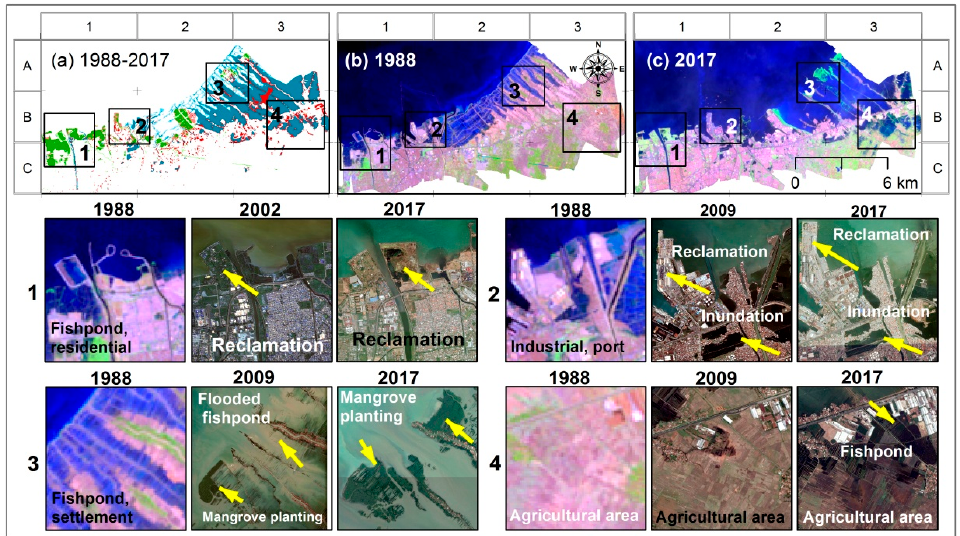
Figure 16. Changes of land use/cover observed in the middle section. ( a ) Spatial distribution of changes from 1988 to 2017. Landsat images with RGB 542 from ( b ) 1988, and ( c ) 2017. Description of pixel colours can be seen in the caption of Figure 14. The four black boxes show zoomed-in areas. The 1988 Landsat and Google Earth images show the type of land use/cover. Agricultural areas, fishponds , mangroves , open water , and settlements were distinguished based on criteria described in the text.